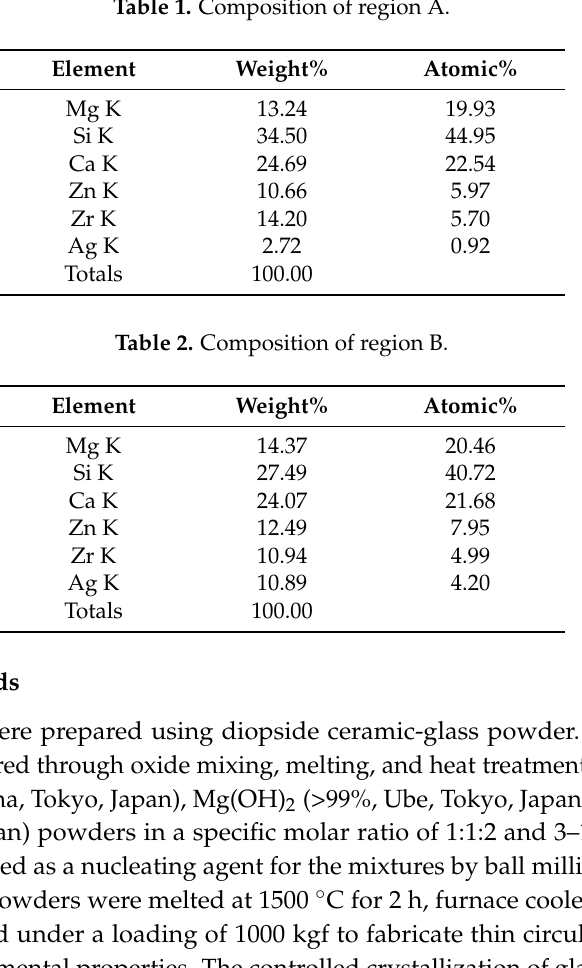
Table 1. Composition of region A.